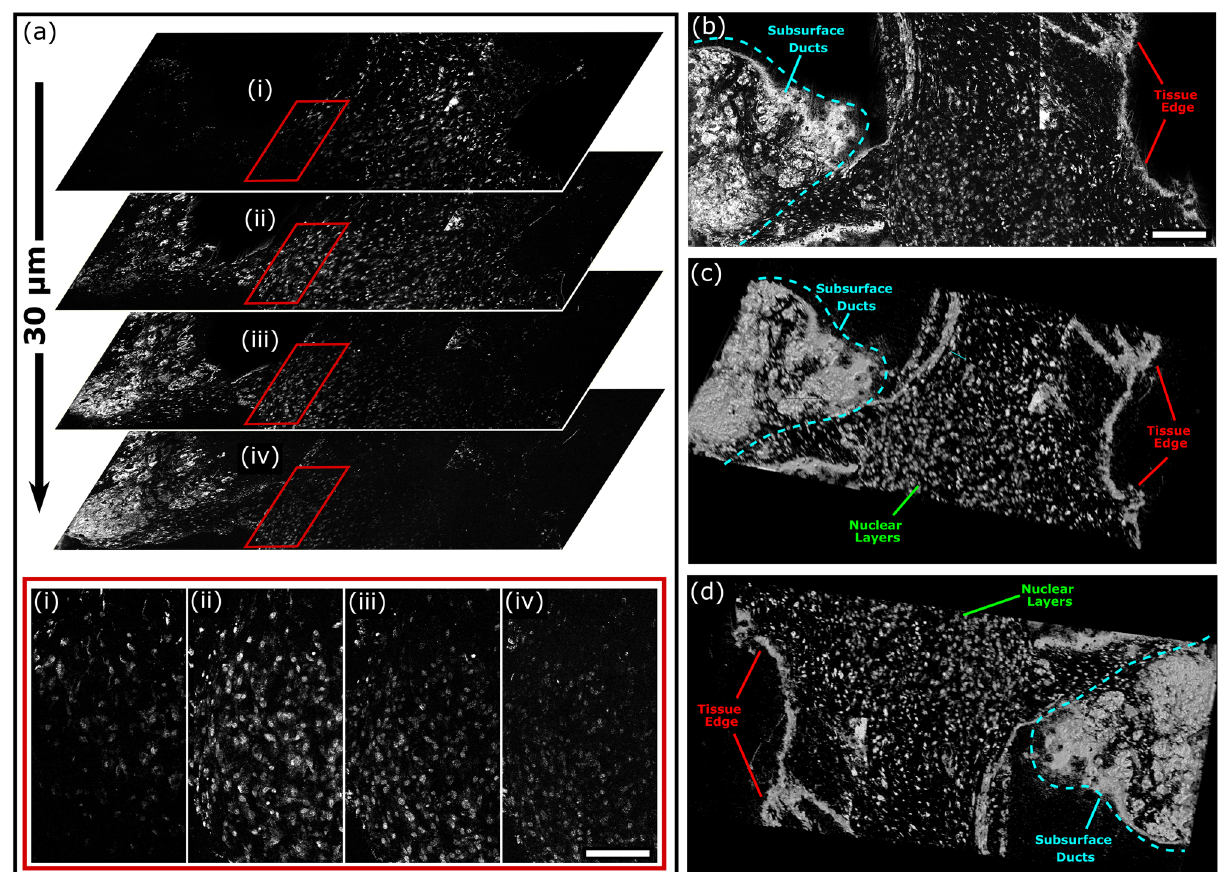
Figure 6. PARS 3D volumetric imaging of subcellular nuclear morphology in unprocessed excised Rattus mammary tumor tissue. ( a ) A subset of the optically sectioned volumetric image stack showing subsurface nuclear morphology from the surface to 30 µm into the tissue. Scale Bar: 125 µm. ( b – d ) Different angular views of the 3D reconstruction of the nuclei within the excised tissue sample. Scale Bar: 200